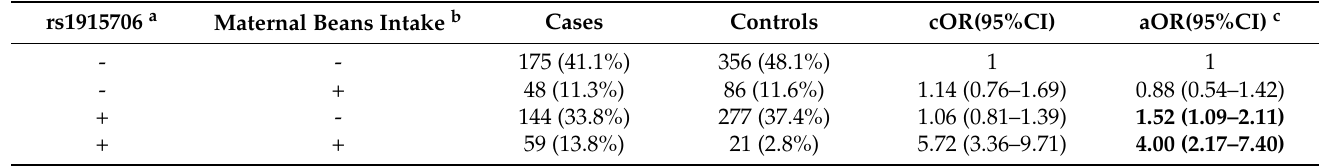
Table 6. Interaction of rs1915706 and maternal beans intake based on crossover analysis.